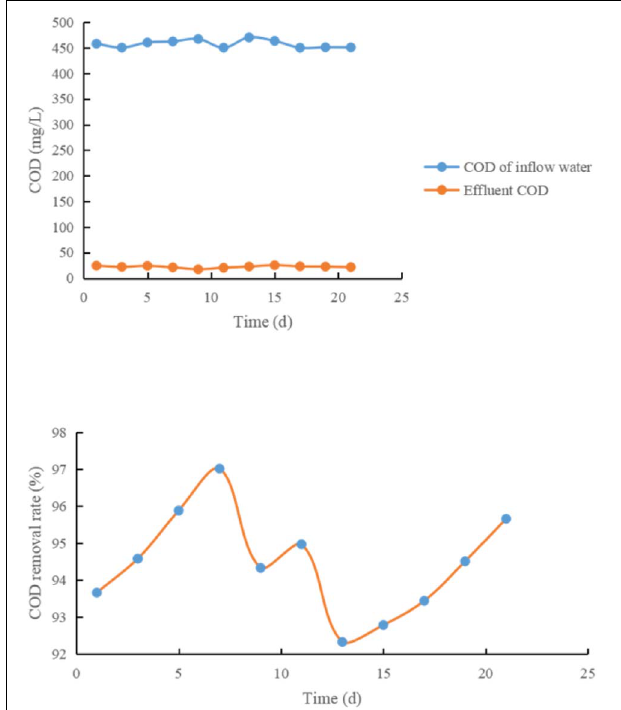
FIGURE 5 | Effect of adding rice washing water on COD removal